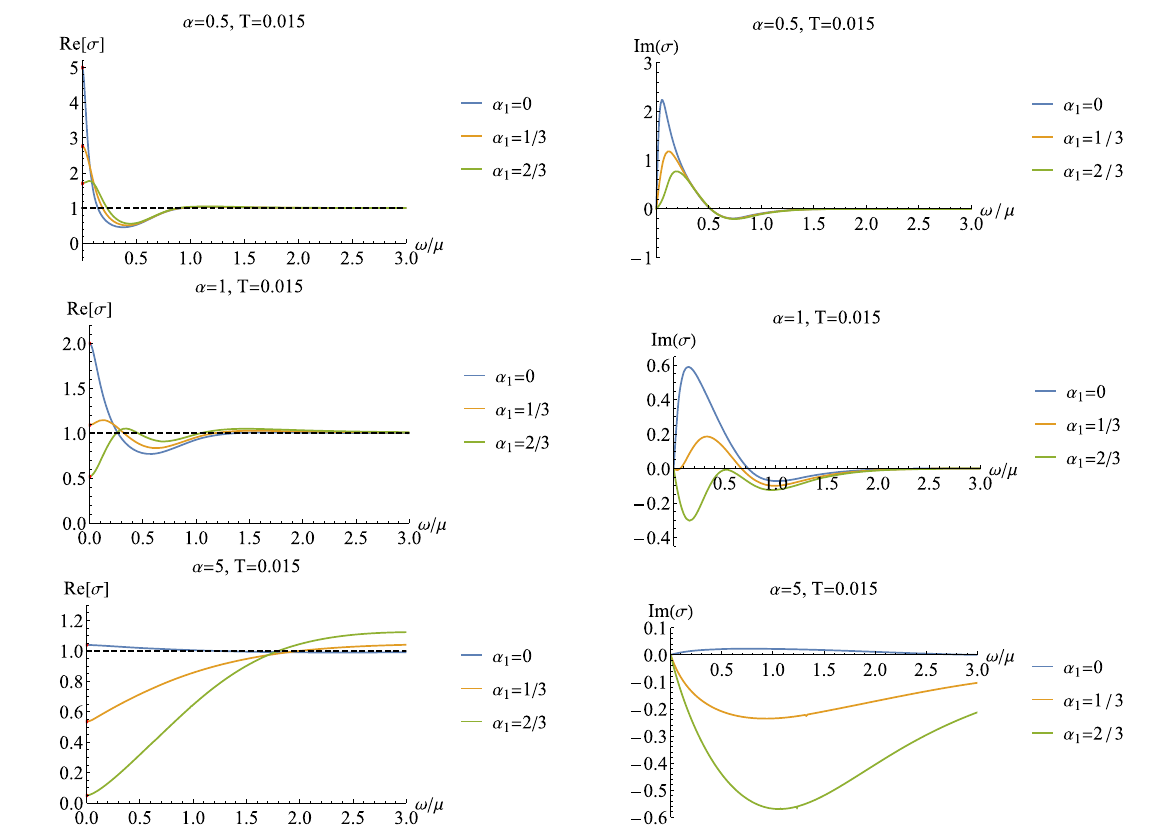
Fig. 2 AC conductivity in the normal state at T = 0 . 015 with different α and α 1 . The red dots correspond to DC conductivity obtained from formula (19). Here we have abbreviated the two dimensionless quantities { T /μ,α/μ } to { T ,α